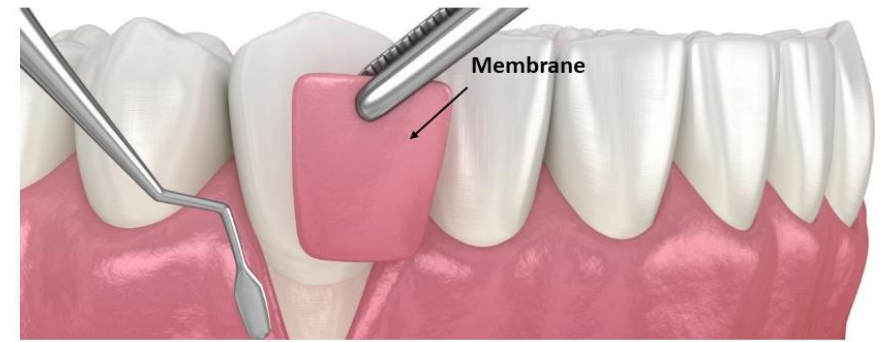
Figure 7. Membrane and its placement in order to act as a